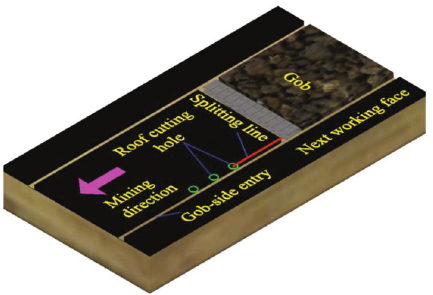
Figure 1: Schematic diagram of roadway formed by roof cutting and pressure